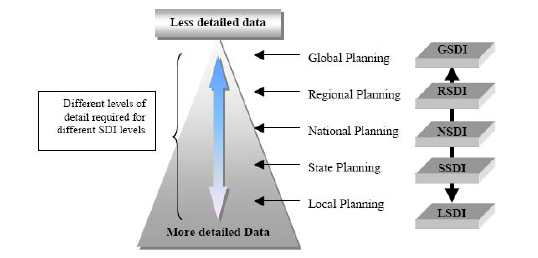
Figure 2: Relationship between Data and Different forms of SDI (Rajabifard et al,